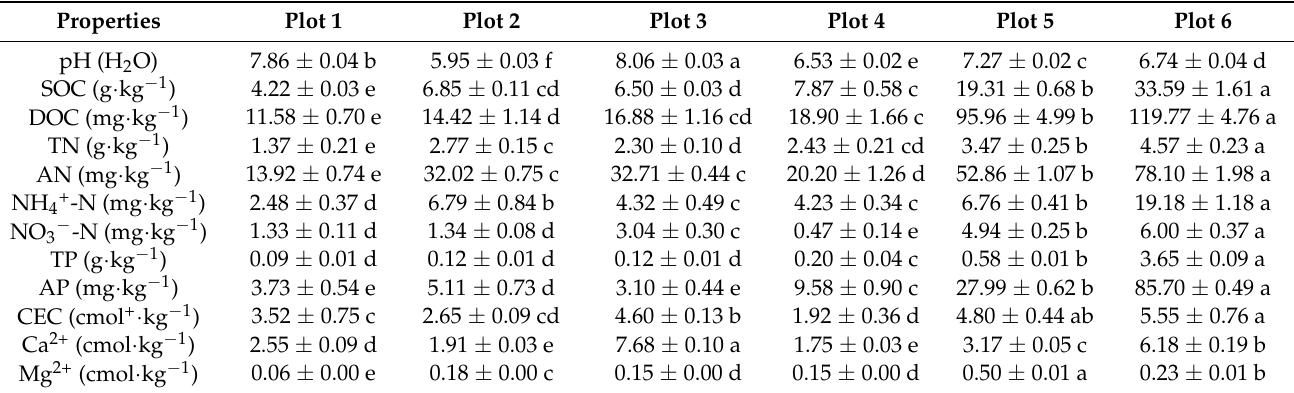
Table 2. Basic physicochemical properties of soil in different